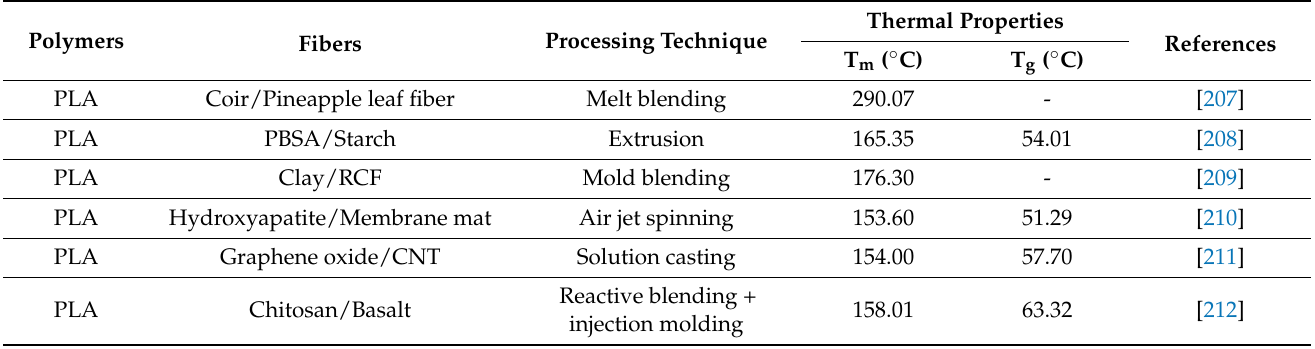
Table 11. Thermal properties of PLA hybrid